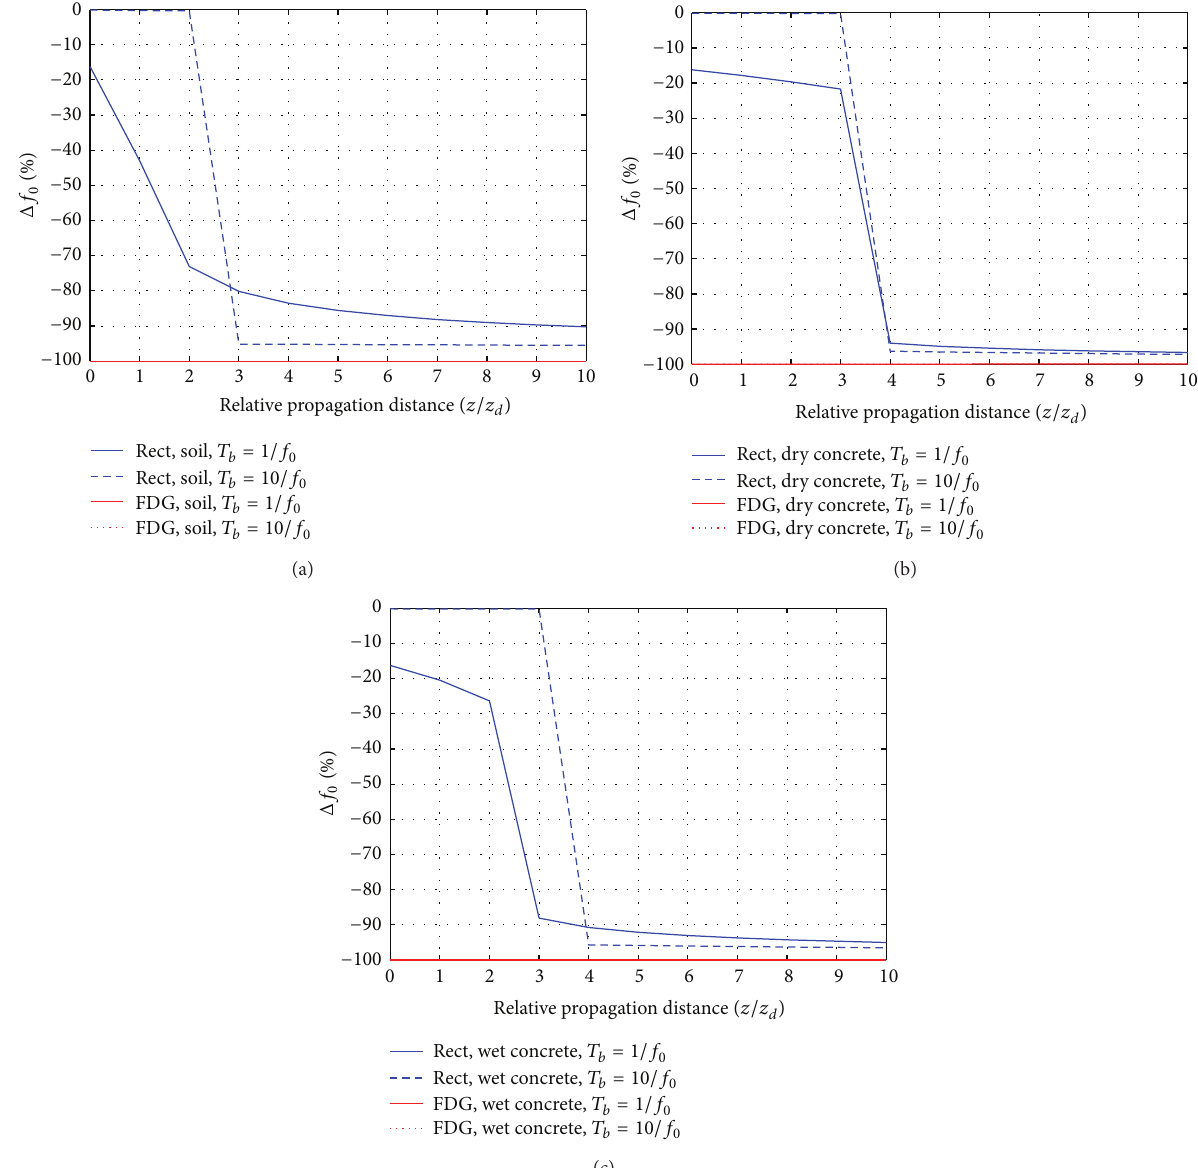
Figure 12: Frequency carrier shifting estimation: (a) soil, (b) dry concrete (0.2%), and (c) wet concrete